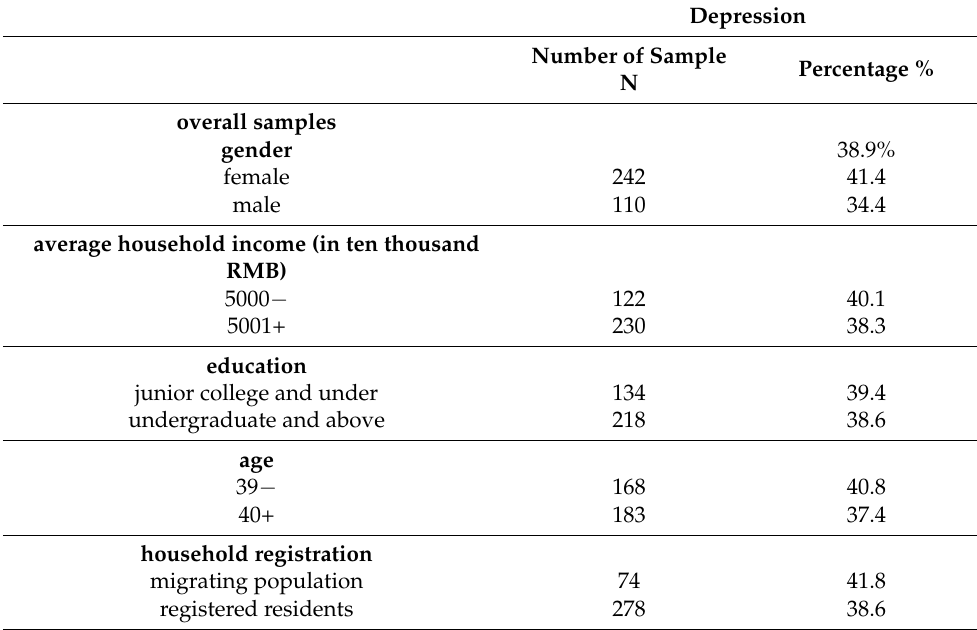
Table 2. The comparison of depression prevalence among different